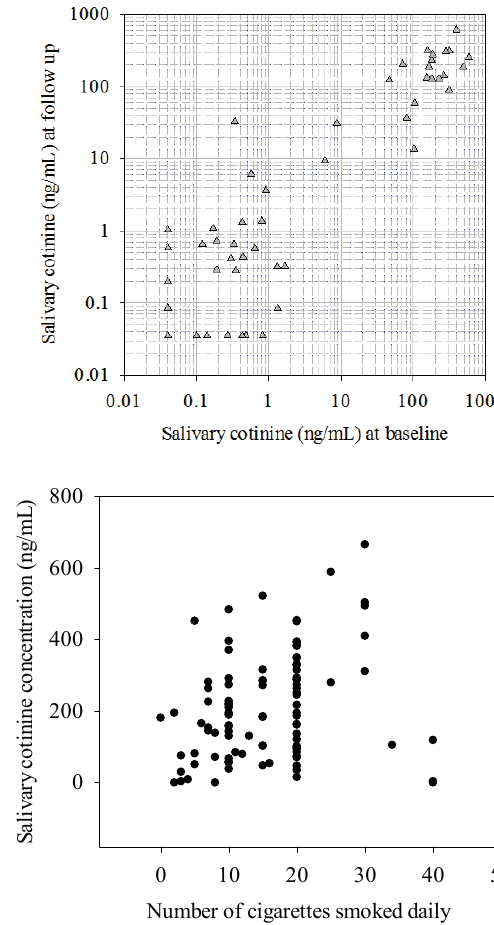
Figure 1. Associations of biomarker concentrations between baseline and follow-up and with the number of cigarettes smoked daily. ( A ) Hair nicotine; ( B ) Salivary